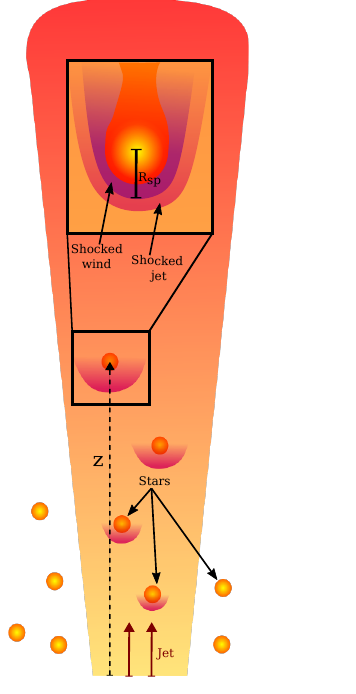
Figure 1. Graphic representation of the scenario studied in this work. Several stars are considered inside the AGN jet, repre- sented by the orange spheres. The interaction of the relativistic jet with the stellar winds produces a pair of bow shocks consist- ing of a pair of shocks, one propagating through the stellar wind and one in the jet. The characteristic size of the bow shocks is given by stagnation point located at a distance R sp ( z ), which increases with the distance z as indicated in Eq. (3). Particles accelerated in a bow shock can be reaccelerated in another bow shocks at larger z .